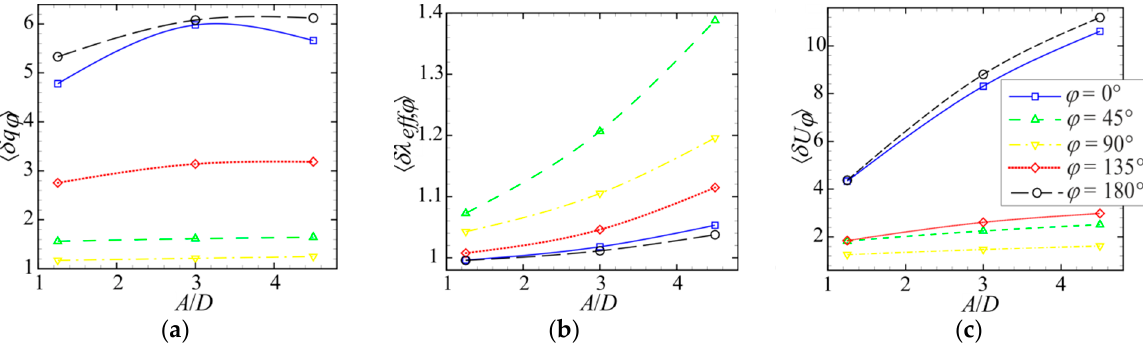
Figure 10. The effect of pulsations on the local flow and heat transfer characteristics at f = 0.25 Hz. ( a ) Variation of heat flux ratio δ q φ = q φ , p / q φ , st with A / D . ( b ) Variation of effective thermal conduc- tivity ratio δλ eff , φ = λ eff , φ , p / λ eff , φ , st with A / D . ( c ) Variation of velocity ratio δ U φ = U φ ,, p / U φ ,, st with A / D .